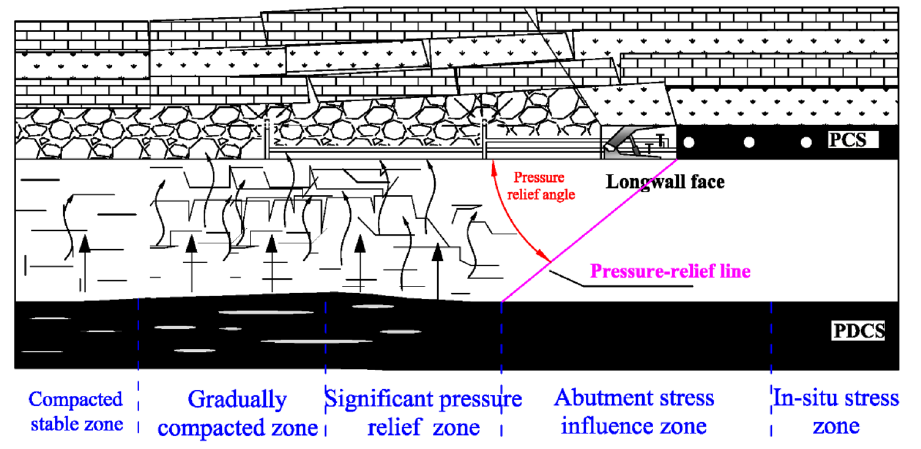
Figure 10. Schematic diagram of different pressure relief zones in PDCS during PCS